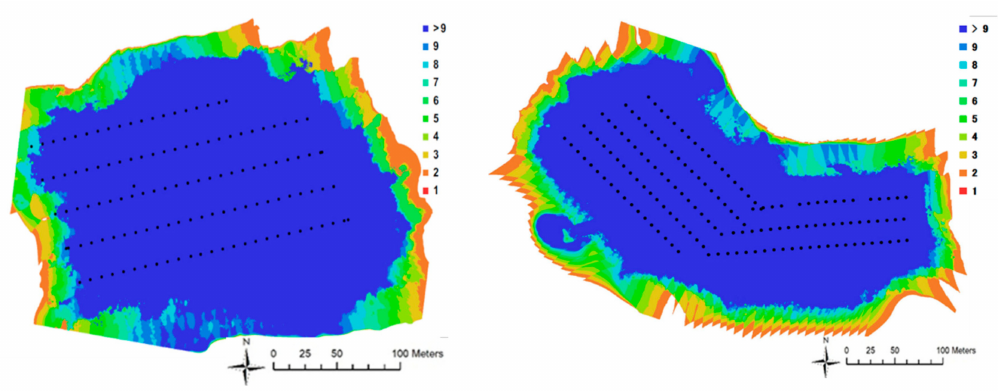
Figure 5. Camera position and the overlap of images. Black dotted lines represent flight paths of Unmanned Aerial Vehicle (UAV). Red to blue color indicates the number of overlapped images taken by UAV.